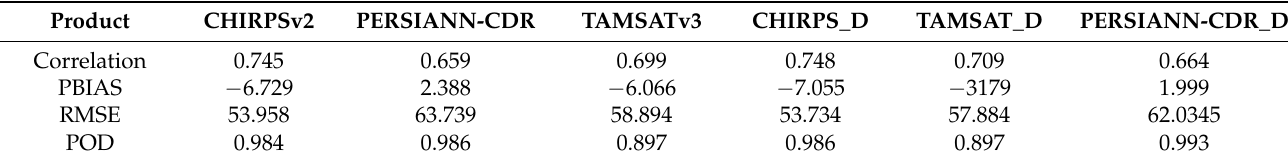
Figure 6. Scatter charts of observed precipitation versus global precipitation products at monthly timescale. Table 4. Monthly statistical indicators of GPPs